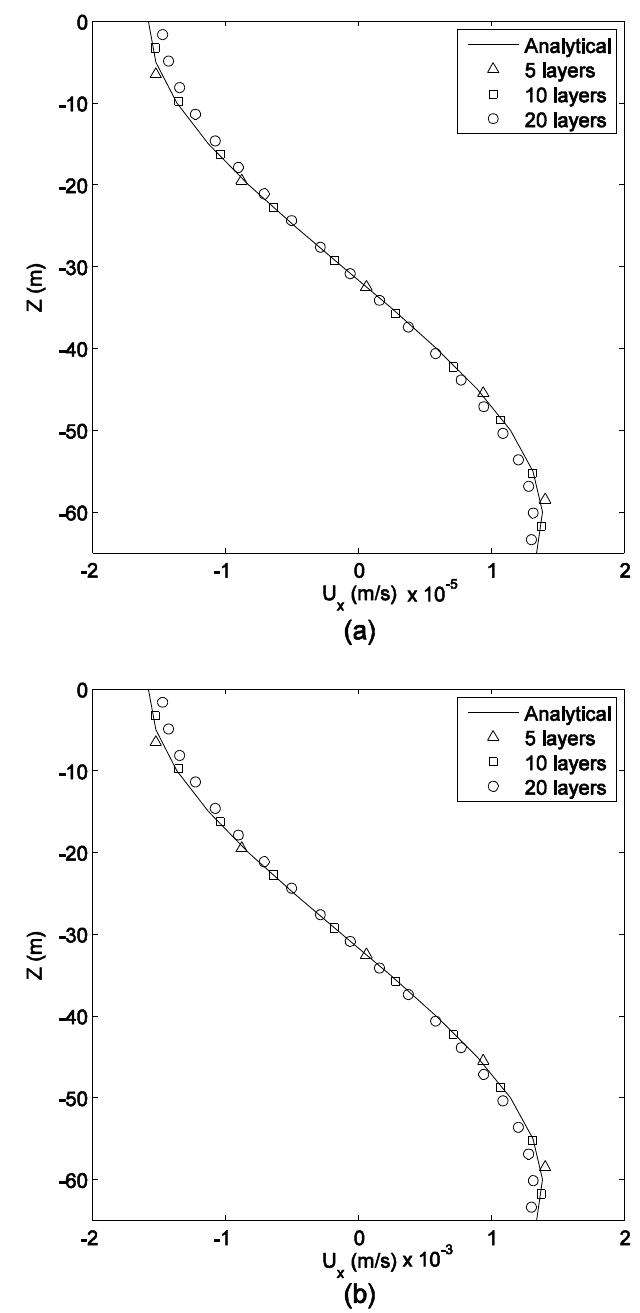
Figure 3. Comparisons of numerical model prediction with an analytical solution for the density-driven case: ( a ) ∂ρ / ∂ x = − 5 × 10 − 7 kg / m 4 , and ( b ) ∂ρ / ∂ x = − 5 × 10 − 5 kg / m 4 . The multilayer MRT-LBM is also validated for combinations of wind-driven and density-driven circulation with W = 0.03 N / m 2 , ∂ρ / ∂ x = − 5 × 10 − 5 kg / m 4 and τ W = 0.3 N / m 2 , and ∂ρ / ∂ x = − 5 × 10 − 4 kg / m 4 . The physical parameters for this case are ∂ρ / ∂ y = 0, ρ = 1025 kg / m 3 , ρ a = 1.2 kg / m 3 , C W = 0.0015, µ = 0.004 m 2 / s, and κ = 0.005 m / s. With the positive x wind direction, as shown in Figure 4, the multilayer MRT-LBM solutions compare well to the analytical solutions for u x profile for the combined e ff ects. Figure 4 indicates that the 10-layer model is su ffi cient to capture the velocity